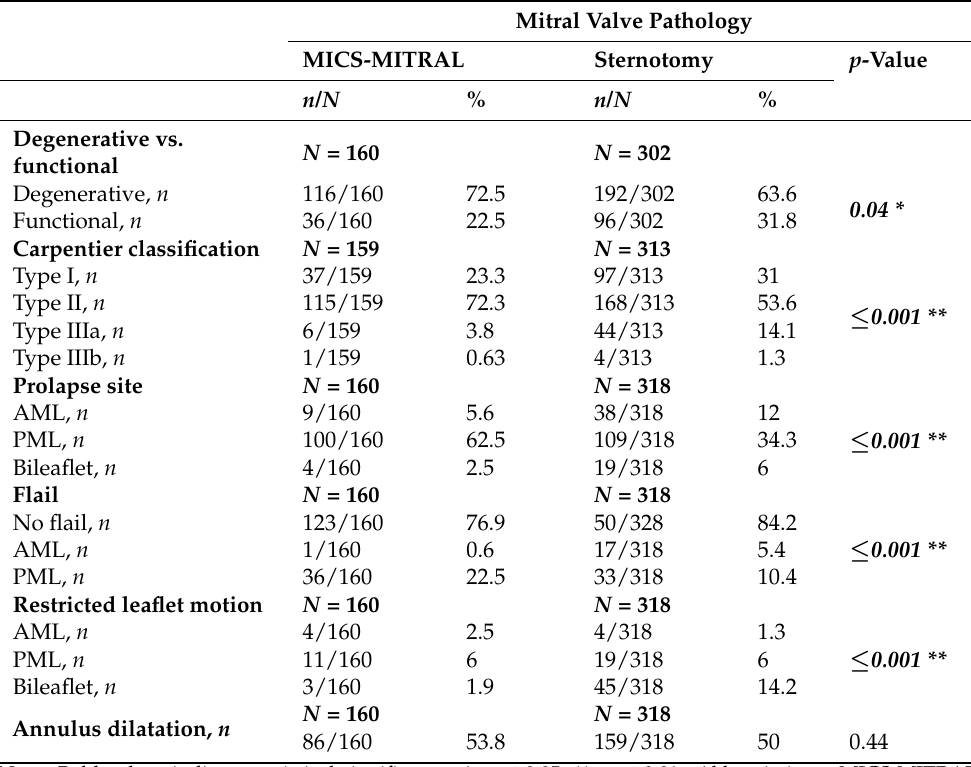
Table 3. Mitral valve pathology and echocardiographic parameters.